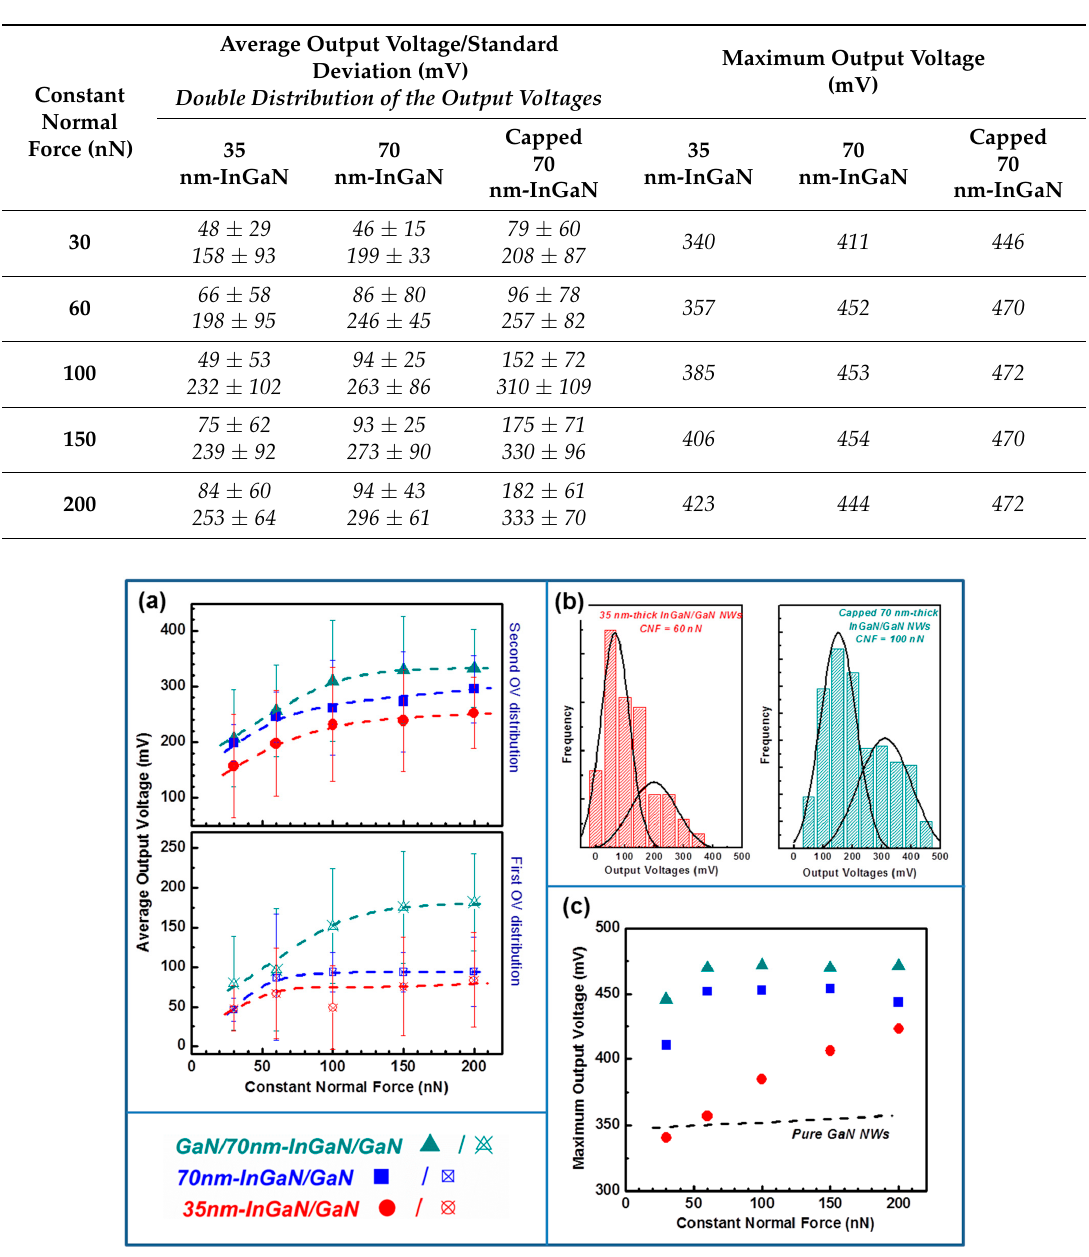
Figure 4. ( a ) Average and ( c ) maximum output voltages measured on InGaN/GaN NWs as a function of the constant normal force for the three sets of samples. For comparison, the maximum output voltages generated by non-heterostructured binary p-doped GaN NWs (from [28]) are also represented by ( c ). ( b ) Histogram distribution of the output voltages generated by 35 nm-thick uncapped InGaN/GaN and 70 nm-thick capped InGaN/GaN NWs respectively for constant normal force (CNF) of 60 and 100 nN.